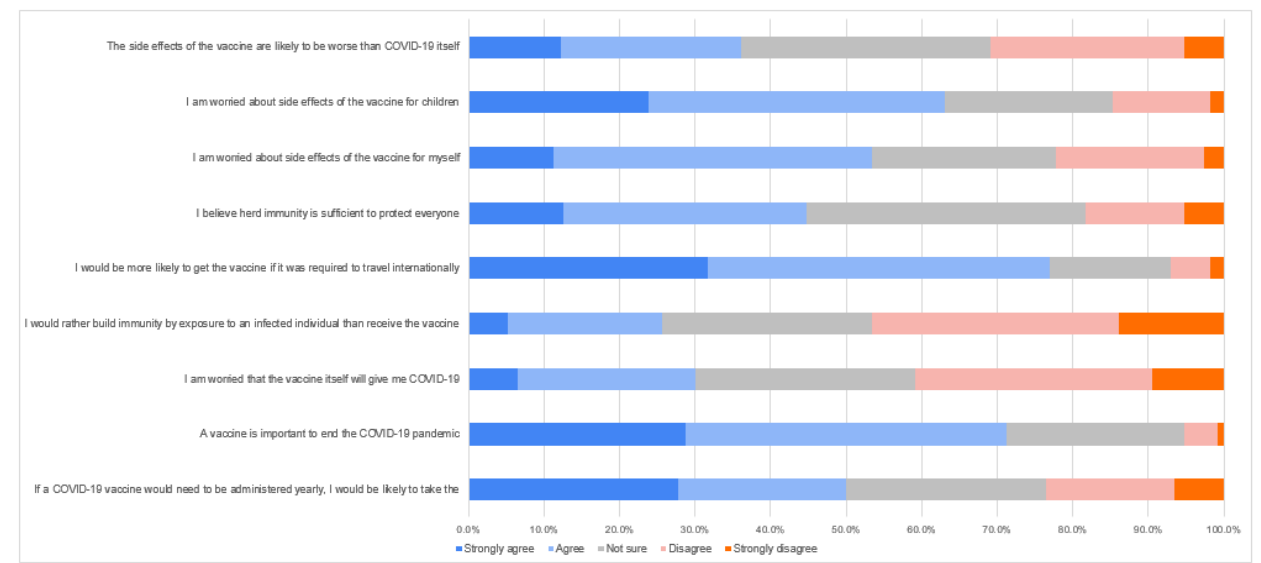
Figure 1. Attitudes and beliefs toward COVID-19 disease, vaccination, and immunity using a five-point Likert scale.